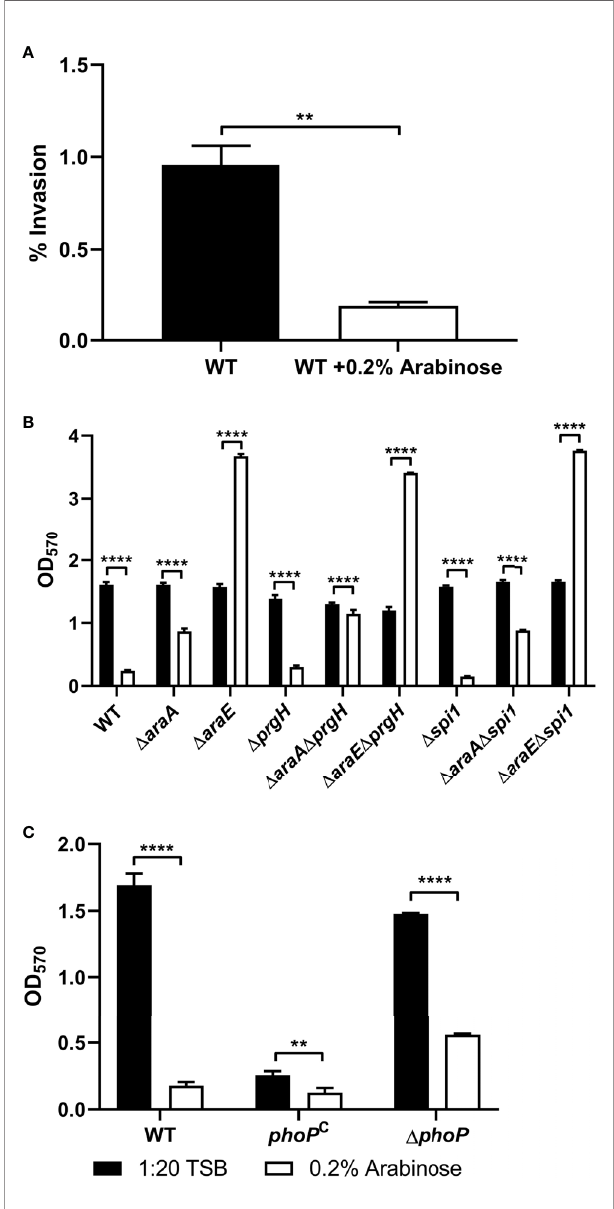
FIGURE 5 | L-arabinose effects host cell invasiveness but invasion genes do not affect bio fi lm formation. (A) HeLa monolayer cells were infected with WT 14028 cells at an MOI of 100 for 1 hour before being washed with 1xPBS and treated with 50 µg/mL gentamicin to remove any extracellular bacteria. Cell lysates were plated for CFU enumeration. WT 14028, D araA , D araE , and various combinations of SPI-1 mutant strains (B) or phoP strains (C) were grown in 96-well plates in 100 µL 1:20 TSB (black bars) or 1:20 TSB with 0.2% L-arabinose (white bars). After 24 hours, planktonic cells were removed, then bio fi lms were washed, heat fi xed, and stained with crystal violet (CV) for relative bio fi lm measurement as determined at OD 570 . Data are mean ± SD, statistical analyses were done using (A) Welch ’ s unpaired t-test or (B, C) two-way ANOVA with Dunnett ’ s multiple comparisons test NS, not signi fi cant ( P >0.05); ** P <0.01; **** P